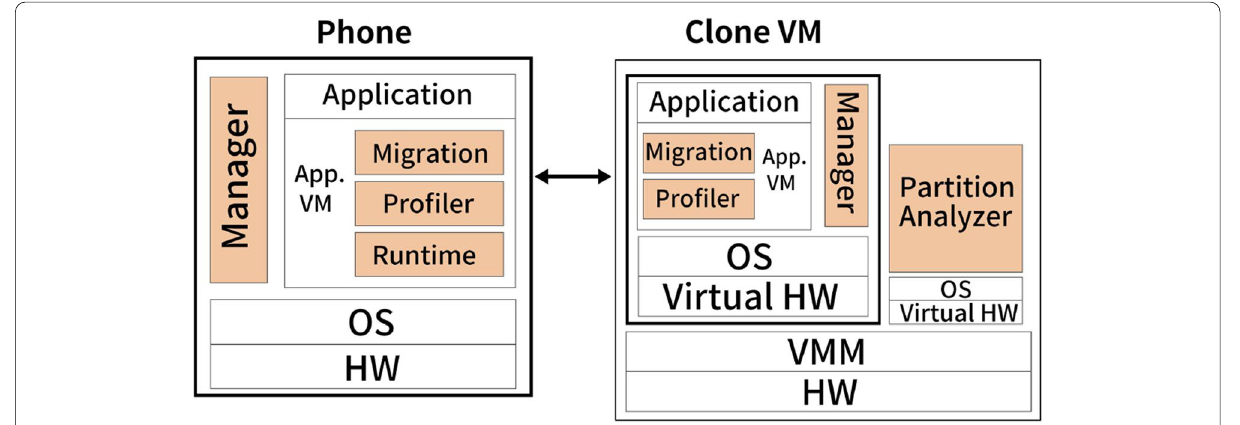
Fig. 3 Architecture of CloneCloud. (Chun et al.